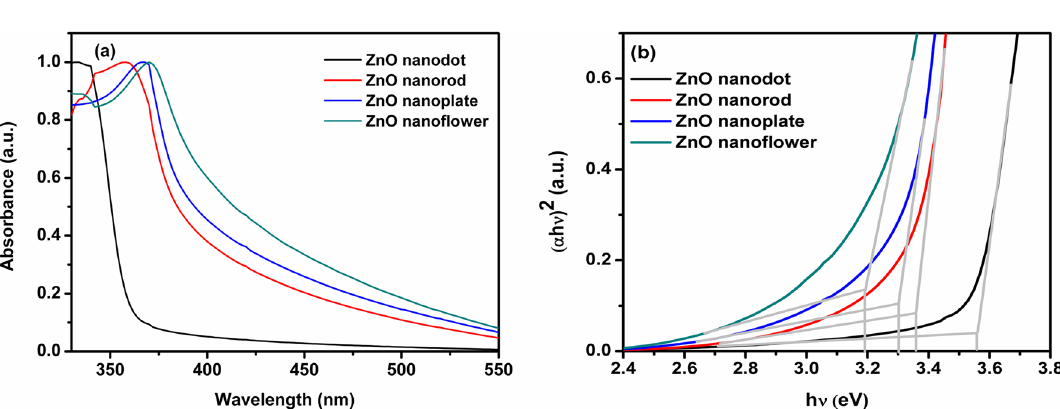
Figure 6. ( a ) UV absorption spectra ( b ) estimation of bandgap of ZnO nanostructures synthesized in distinct